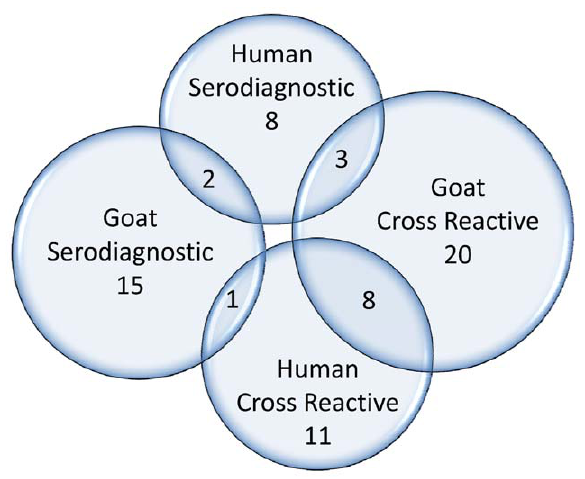
Figure 6. Serodiagnostic and cross-reactive antigens for humans and